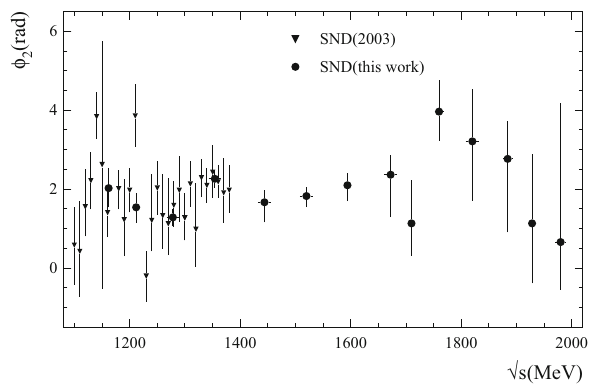
Fig. 8 The relative phase between the ωπ 0 and ρ( 770 )π amplitudes measured in this work in comparison with the results of Ref.